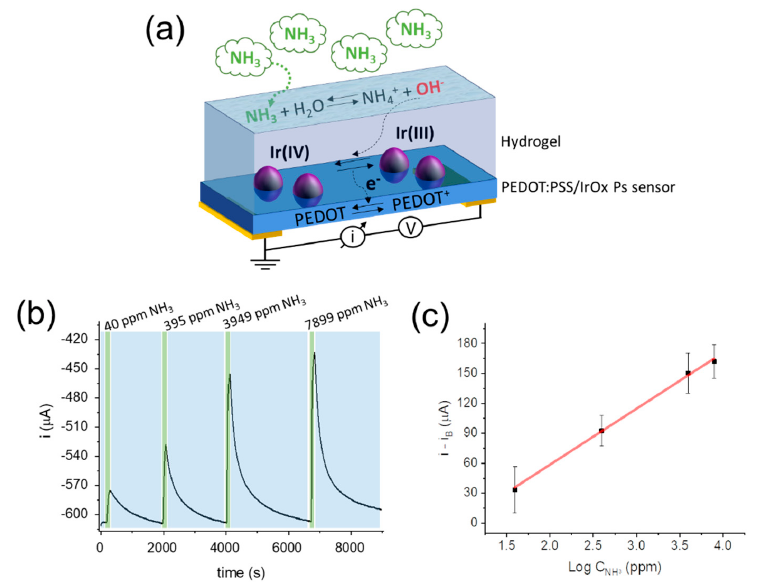
Figure 4. ( a ) Schematic of the optimised two-terminal gas sensor working principle. ( b ) Current vs. time response of the NH 3 sensor and ( c ) calibration curve (R 2 = 0.997) obtained from three repeated measurements. NH 3 -rich air streams were delivered for 100 s (green shadows) and alternated to air flow until full baseline recovery (blue shadows). Flow rate 2 L min –1 ; V app = –200 mV. As NH 3 gas molecules reach the hydrogel surface, they diffuse inside the hydrogel structure and solvation occurs. Consequently, the acid-base equilibrium described in Equation (1) takes place and OH – ions are released that increase the pH of the aqueous environment. This pH variation in the hydrogel corresponds to the chemical signal trans- duced by the PEDOT:PSS/IrOx pH-sensitive material. In particular, the pH affects the re- dox equilibrium involving the potentiometric transducer IrOx, i.e., the redox couple Ir IV /Ir III present as IrO 2 and Ir(OH) 3 or IrOOH, which can be described by the Nernst equa- tion [28]: (cid:3404) 𝐸 (cid:2868) + (cid:3019)(cid:3021) (cid:3007) ln (cid:4670)𝐻 (cid:2878) (cid:4671) (2) where E is the electromotive force generated by the spontaneous redox process, E 0 is the standard reduction potential of the redox couple, R is the gas constant, T is the absolute temperature, and F is the Faraday constant. As a result of a local pH increase within the hydrogel, the oxidation of Ir(III) species to Ir(IV) is favoured and an electron is extracted from the IrOx Ps. Thanks to the intimate contact between IrOx Ps and PEDOT:PSS, the electron is directly injected into the polymer film where PEDOT + reduction takes place. Due to its p-doped character, the organic semiconductor decreases its conductivity and, if a small Δ V is applied across the two-terminal sensor, the generated current decreases as well. The response of the optimised two-terminal sensor (Figure 1c) to gaseous NH 3 was investigated using the calibrated stripping system (Figure S1). A Δ V of − 200 mV was ap- plied between the two terminals of the sensor, and the generated current was recorded over time, while the NH 3 -rich air streams with controlled NH 3 concentration were deliv- ered to the sensing chamber for 100 s at 2 L min − 1 and alternated with air streams until baseline recovery (Figures 4b and S14). In accordance with the transduction mechanism discussed above, a sharp current de- crease was observed right after the NH 3 -rich air flow entered the detection chamber, sug-